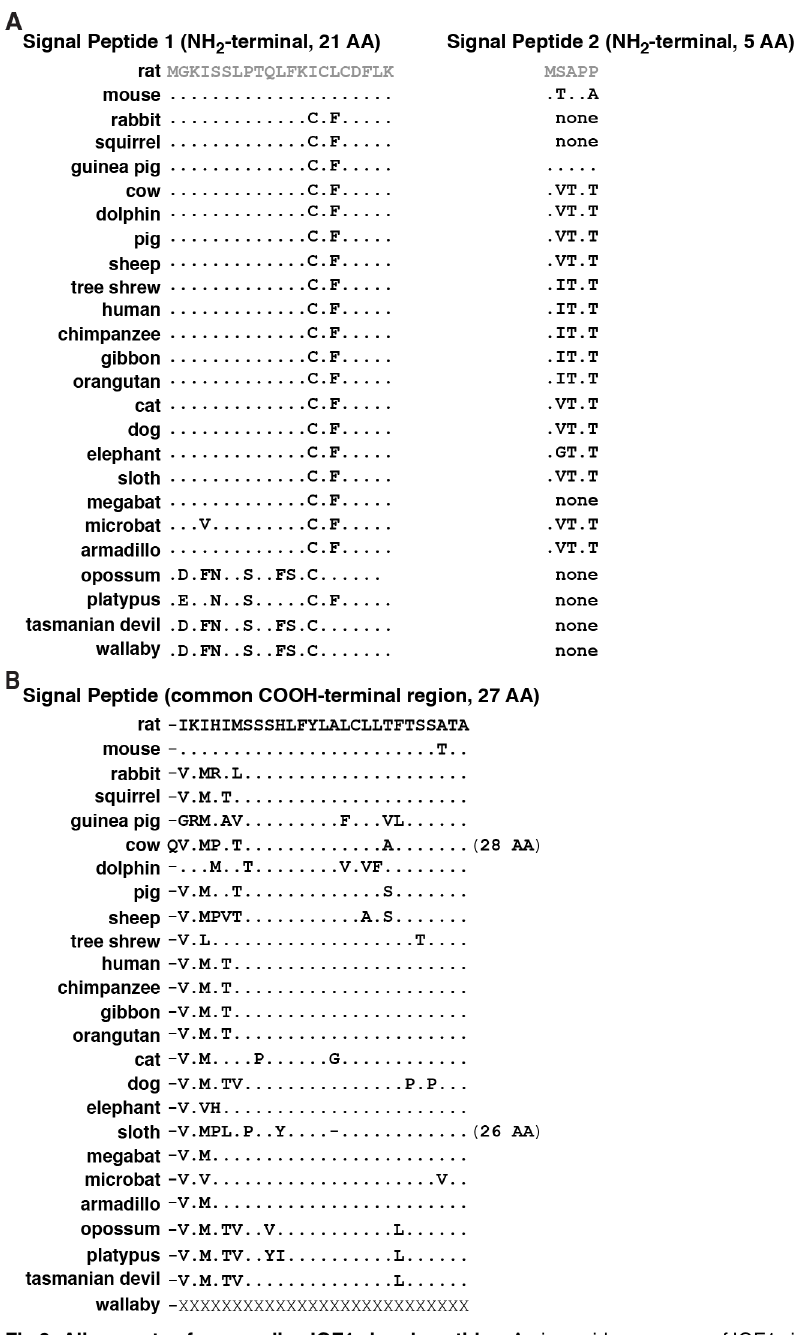
Fig 3. Alignments of mammalian IGF1 signal peptides. Amino acid sequencesof IGF1 signalpeptides. A . The initial 21 residues of signalpeptide1 are encodedby IGF1 / Igf1 exon 1. B . The first 5 residues of signal peptide2 are derivedfrom exon 2. The remaining27 amino acids in each signal peptideare from exon 3. For A and B, identitiesare noted by dots, a dash indicatesno residue,and X depicts an unknownamino acid. The color of rat IGF1 amino acids corresponds with the map in Fig